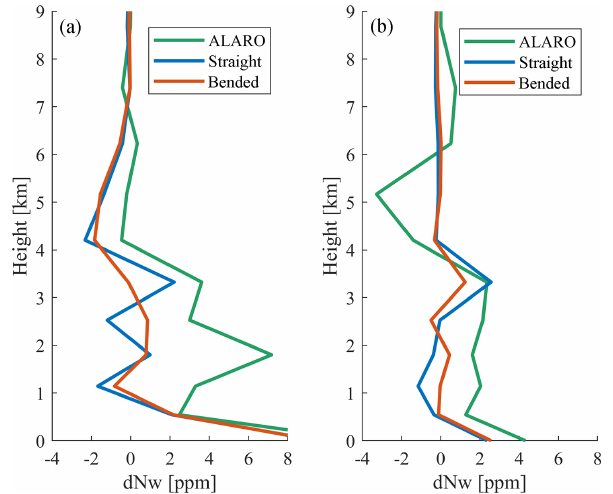
Figure 8. Differences in wet refractivity between radiosonde, ALARO and the two tomography solutions based on straight-line (blue) and bended ray tracing (red) as an example for 1 May 2013 at 03:00UTC (a) and 31 May at 03:00UTC (b)